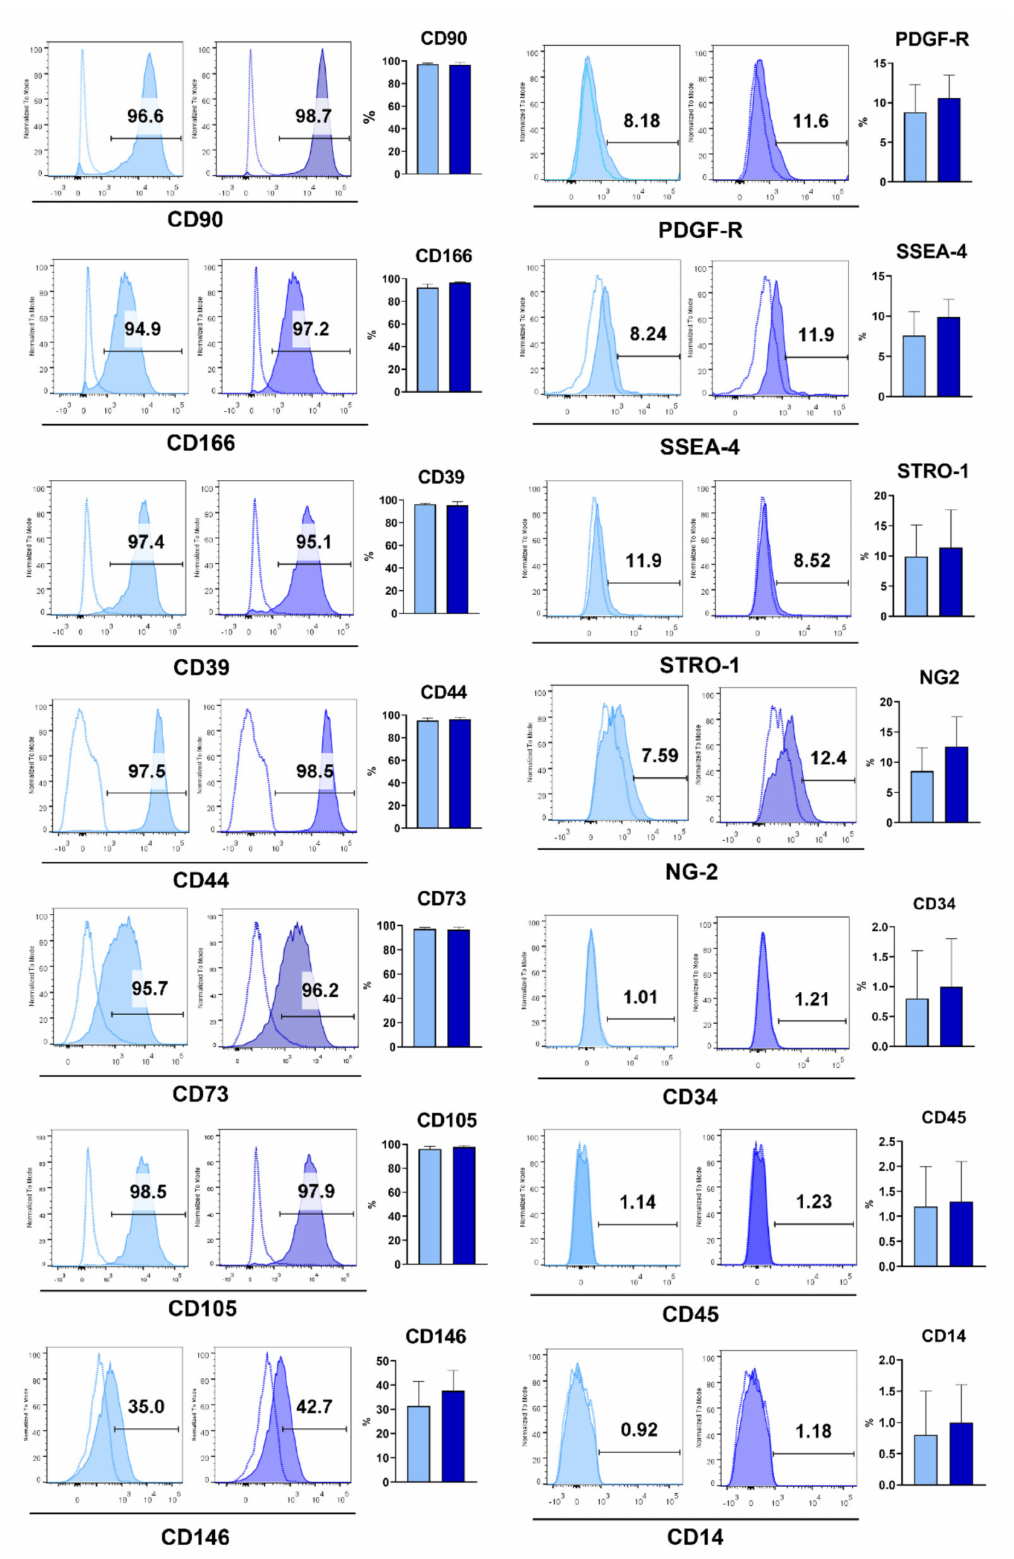
Figure 3. Expression of MSC markers on H- and P-GMSC lines. The methodology for cell staining and analysis is described in detail in Materials and methods. Histograms are representative from one of each line. The bars are placed according to the controls. Vertical columns represent the mean percentage of positive cells ± SD; n = 8 (H- or P-GMSC